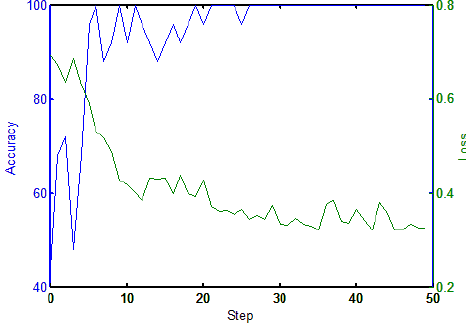
Figure 5. Matching network error and accuracy curve.